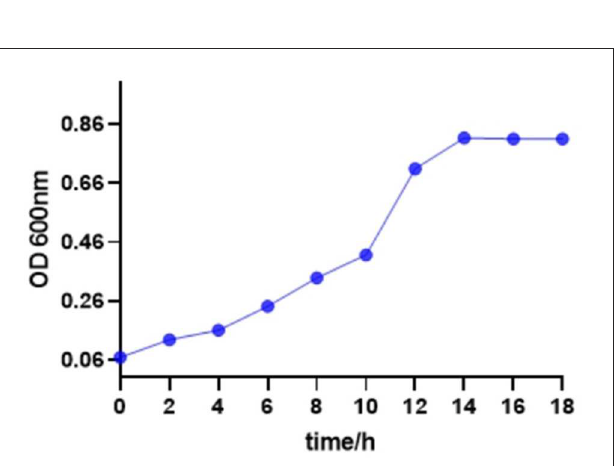
FIGURE1 Growth curve of Salmonella enteritidis .